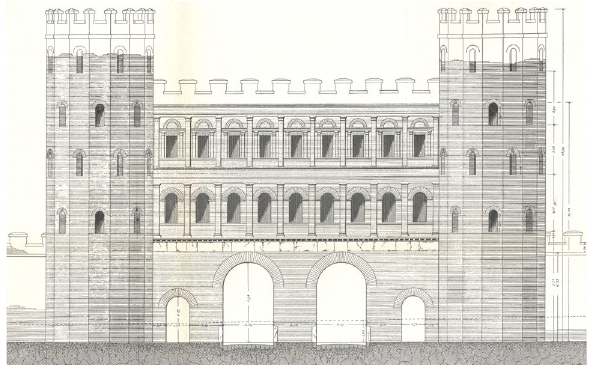
Figure 3 . Carlo Promis. Survey of Porta Palatina, 1869.